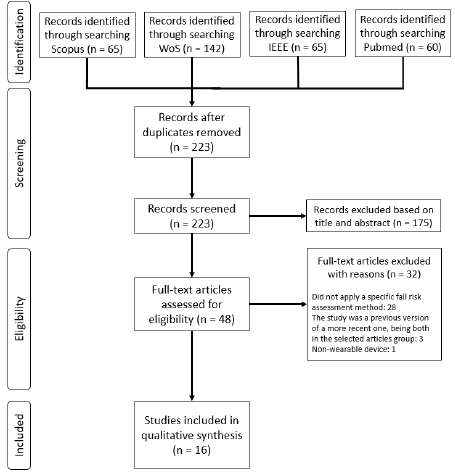
Figure 1. PRISMA flow diagram.